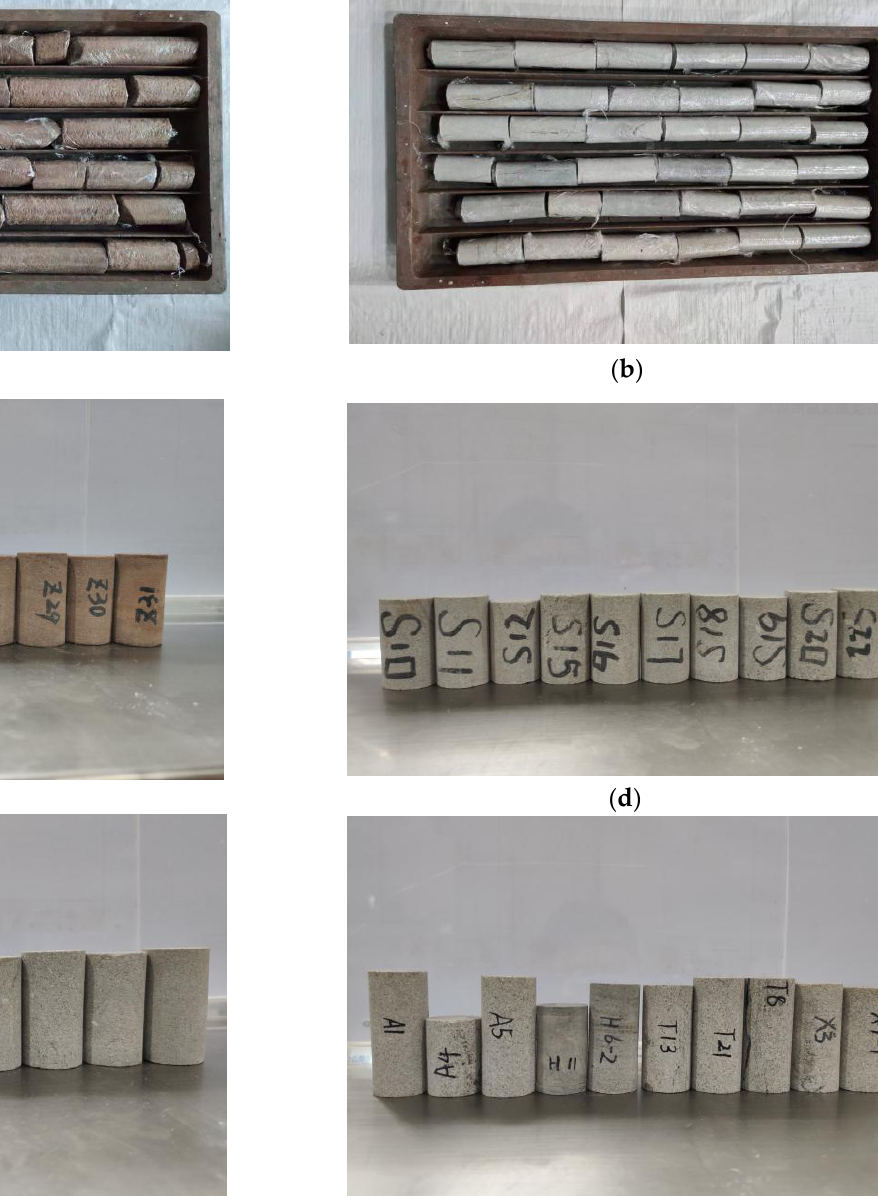
Figure A9. Some original samples and processed samples. ( a ) Original samples of the Jurassic sandstone collected from the borehole J3-1 of the Anju coal mine, with a diameter of 50 mm. ( b ) Original samples of the Shanxi Formation sandstone collected from the No. 12 mining area of the Tangkou coal mine, with a diameter of 50 mm. ( c ) Standard plunger rock samples of Jurassic sandstone with a diameter of 25.4 mm and heights of 25.4–50.8 mm, for porosity and permeability tests (From Anju coal mine). ( d ) Standard plunger rock samples of Shihezi Formation sandstone with a diameter of 25.4 mm and heights of 25.4–50.8 mm, for porosity and permeability tests (From Longyun coal mine). ( e ) Standard plunger rock samples of Shanxi Formation sandstone with a diameter of 25.4 mm and heights of 25.4–50.8 mm, for porosity and permeability tests (From Tangkou coal mine). ( f ) Standard plunger rock samples of Shanxi Formation sandstone with a diameter of 25.4 mm and heights of 25.4–50.8 mm, for porosity and permeability tests (From Anju coal mine).